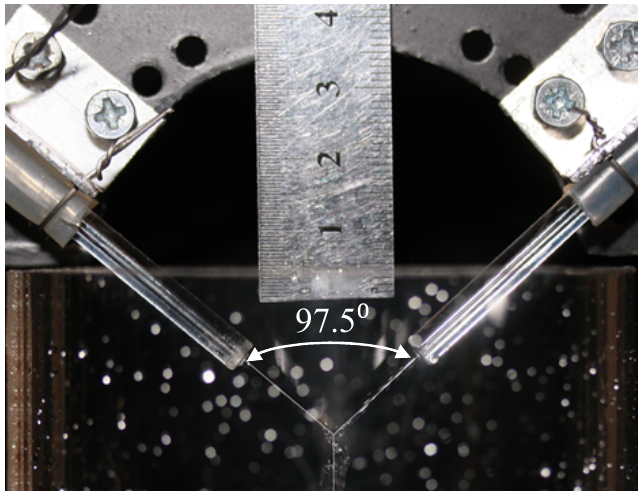
Figure 2. Photograph of the laboratory setup for studying the geometry and conditions for the formation and decomposition of the liquid sheet from open-frame MRFIJ. 2θ = 97.5°, d j = 1.0 mm. The distance between the nozzles is B = 25 mm. Distance from the exit from the nozzle to the point of collision L = 17 mm.